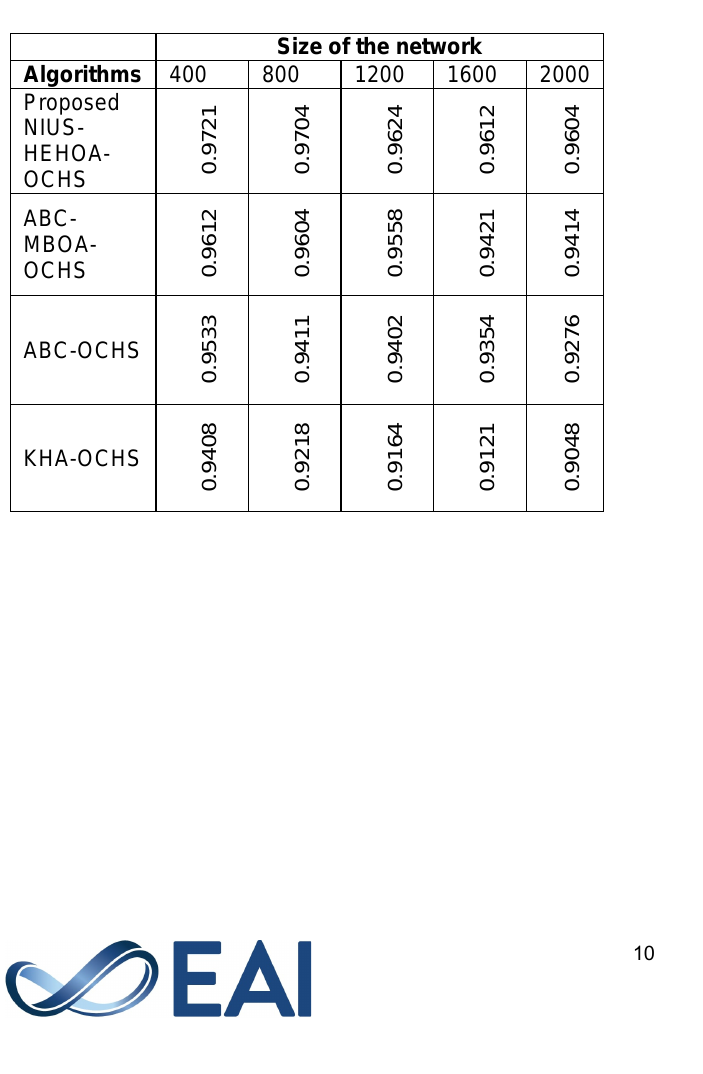
Table 2. Mean packet delivery rate for the proposed NIUS-HEHOA-OCHS